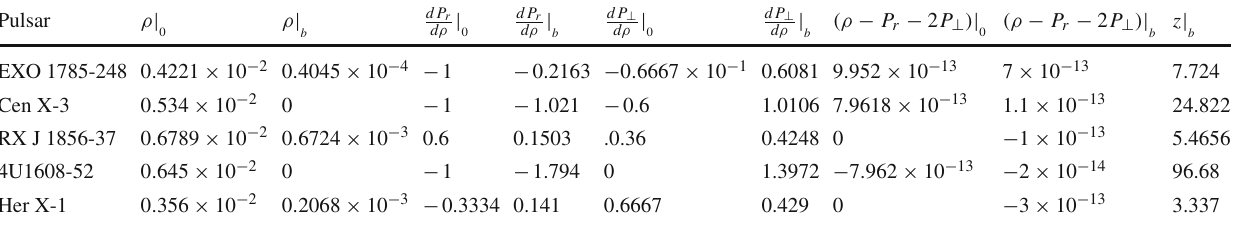
Table 3 Values of physical quantities at c 1 = − 0 .